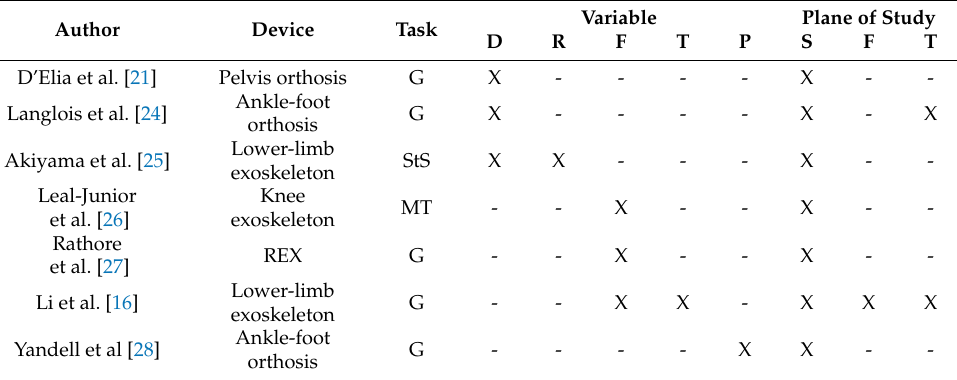
Table 1. Quantitative studies of lower limb devices. The variables involved are one-dimensional displacement (D), one-dimensional rotation (R), force (F), torque (T), and power (P). The analysis is defined through gait (G), movement tasks (MT), and sit-to-stand (StS). The planes of study are divided into sagittal (S), frontal (F), and transverse (T). The X stands for including this variable or plane in the related